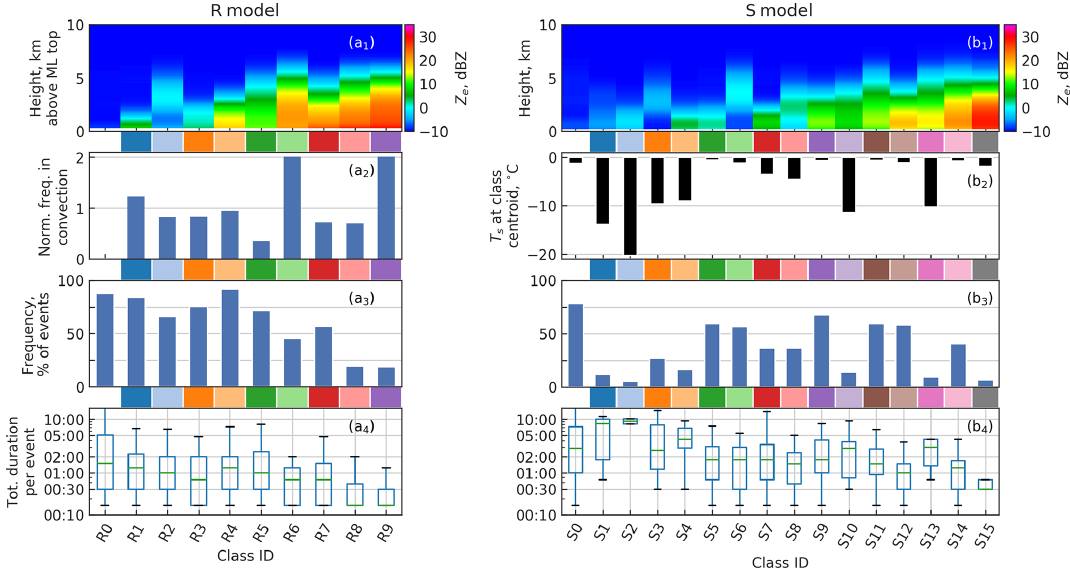
Figure 9. Statistics on frequency of each profile class. Classes are identified by class centroid Z e (a1, b1) and class centroid T s for snow profile classes (b2) , with color codes between the panels and class IDs at the bottom. Panel (a2) has the ratios of the number of profiles in convective cases per class to the expected value in uniform distribution. In (a4, b4) , the class frequencies are given as percentage of events (a3, b3) and total durations (a4, b4) within